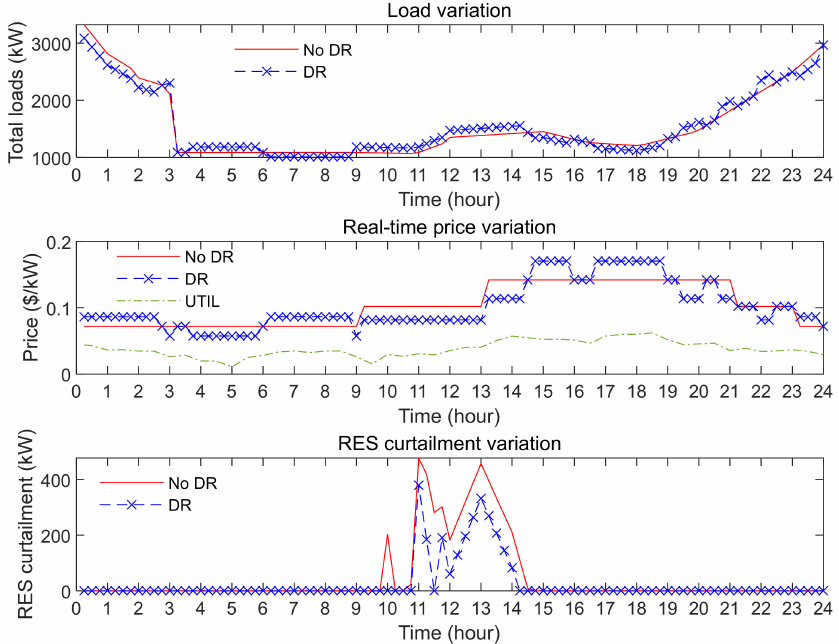
Figure 7. Variations of load demand, real-time prices, and RES curtailment for load type B (the distribution operator cannot sell electricity to the utility